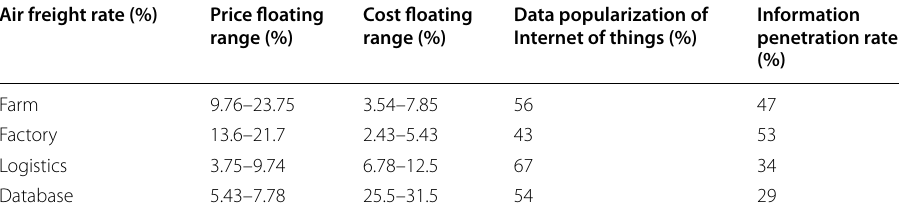
Table 2 The impact of Internet of things on green logistics information network system of agricultural